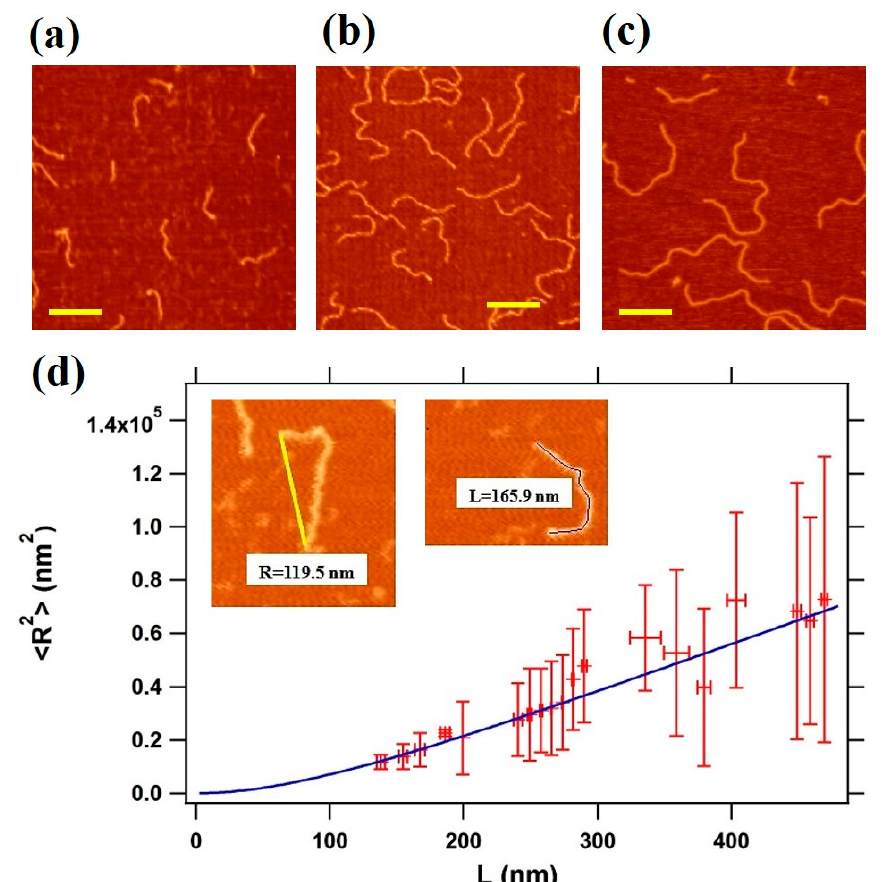
Figure 2. ( a – c ) Representative non-contact atomic force microscopy (AFM) images of DNA on mica performed in air. DNA molecules of 2 nM of various lengths ( a : 495 bp DNA, b : 807 bp DNA, and c : 1350 bp) in buffer solution were incubated for 1 min at room temperature. The scale bar corresponds to 200 nm; ( d ) the mean square end-to-end distance <R 2 > as a function of the contour length (L), as calculated from AFM 138 images; the blue line is the fitting curve obtained using Equation (1), which gives a persistence length of 45.0 ± 0.3